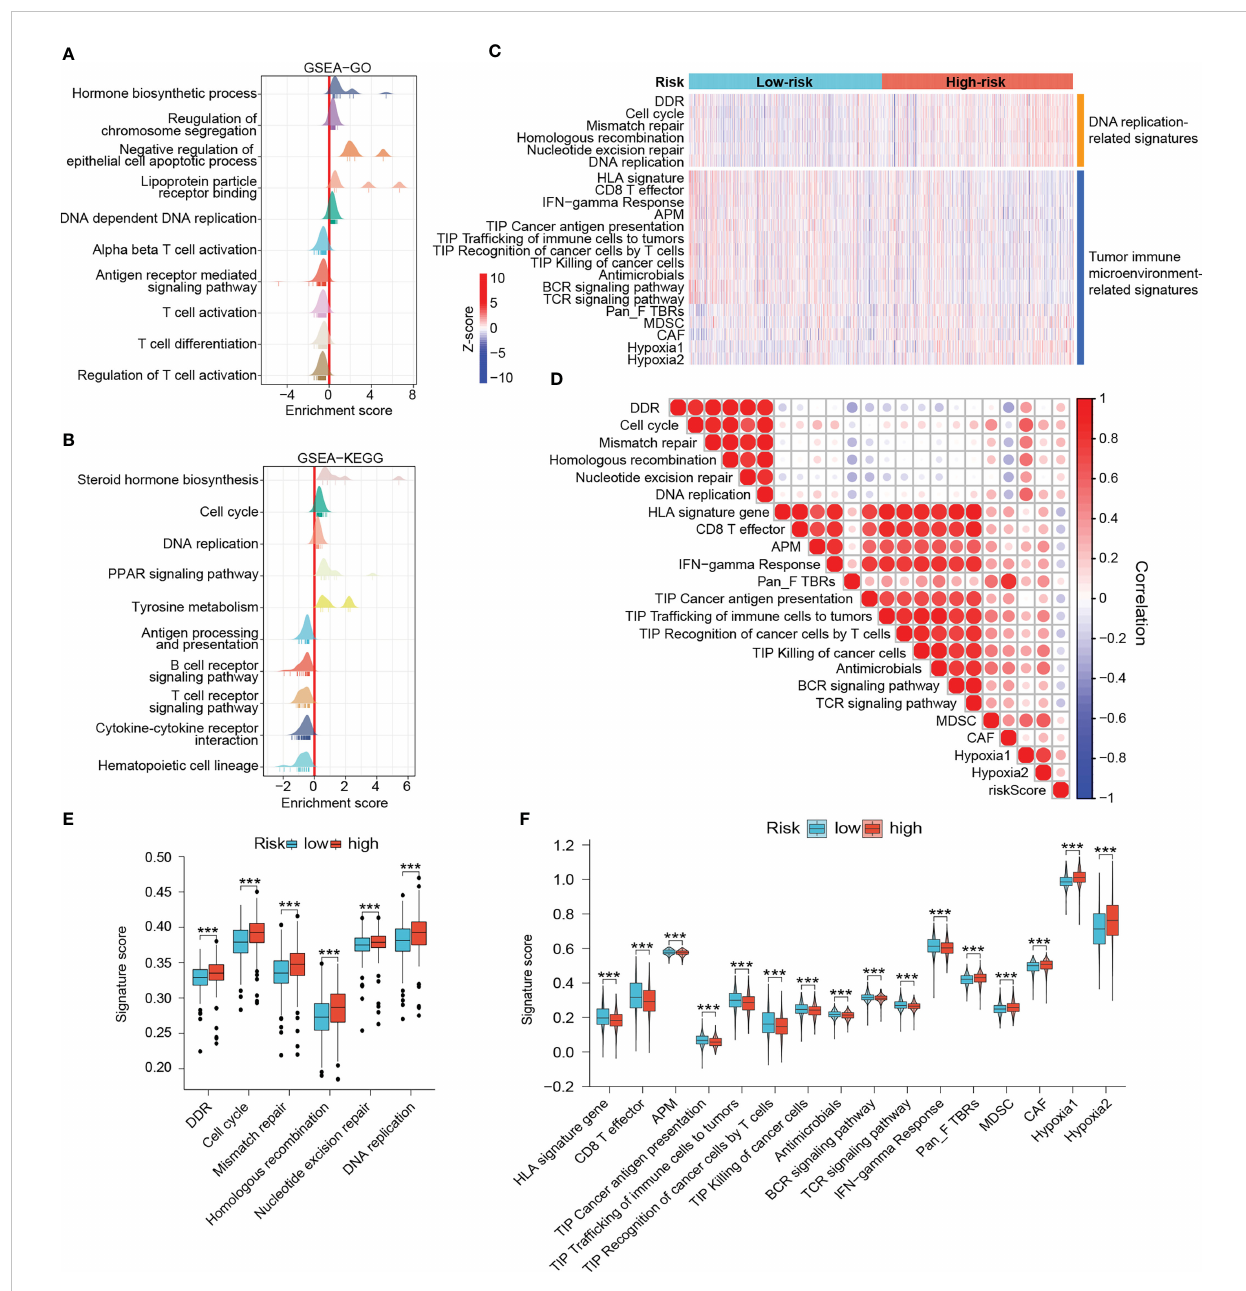
FIGURE 9 Outlining the DNA damage response and antitumor immunity landscapes. (A, B) GSEA results. In these ridge plots, an enrichment peak greater than 0 indicates that the pathway/term is enriched in the high-risk group while conversely, it is enriched in the low-risk group. (C) Heat map of DNA damage response and antitumor immunity signatures in risk groups. The color from blue to red represents the score from low to high. (D) Heat map of correlation between risk scores and different signatures. In this heat map, the size of the circle represents the statistical signi fi cance and the color represents the correlation. The color from blue to red represents the negative to positive correlation. Differential scores of DNA damage response (E) and antitumor immunity (F) between risk groups. (***P <